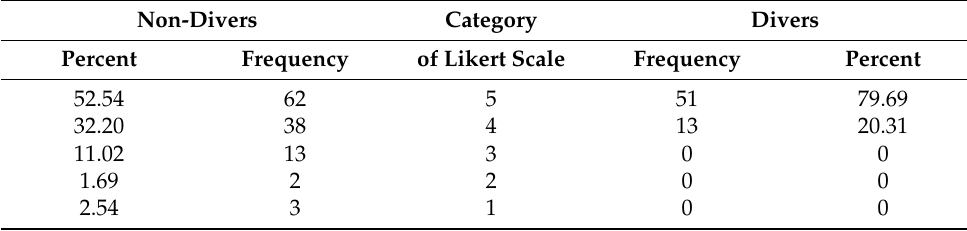
Table 2. Scuba diving impact on the mental condition.